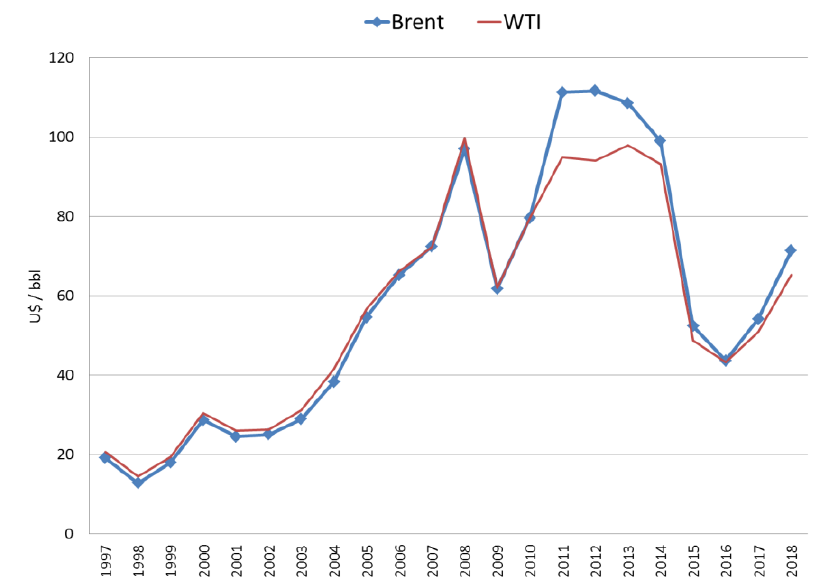
Figure 3. Crude oil benchmark annual prices (Brent and West Texas Intermediate (WTI) spot, nominal)—1997 to 2018. Data source: U.S. Energy Information Administration [12 ] .